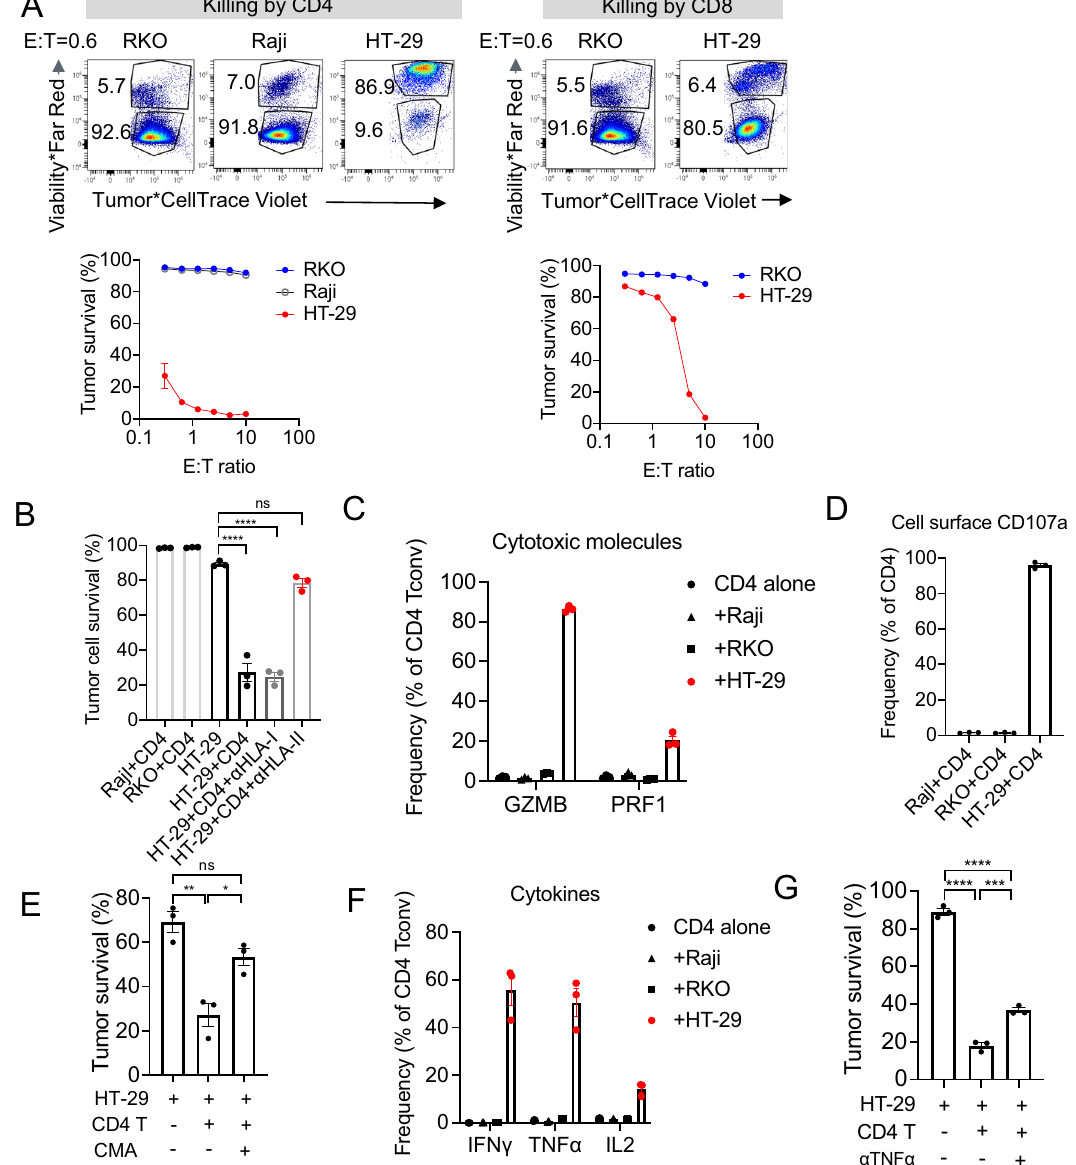
Fig. 6 CD4 T cells mount speci fi c HLA-II-restricted killing of HT-29 tumor cells. A Tumor killing assay using splenic CD4 and CD8 T cells of tumor- regressing mice. CD3 T cells were expanded with HT-29 cells for 2 weeks, followed by CD4 and CD8 T cell isolation and tumor co-culture for 3 days. Tumor cell viability was examined as the readout of the assay. RKO and Raji tumor cells were used as negative controls. E:T ratio: effector to target ratio. B Tumor killing assay using CD4 T cells from regressing tumors with HLA-II blockade. C , D Intracellular staining of cytotoxic molecules at day 2 and cell surface staining of CD107a at the end of the killing assay. E Tumor killing assay using CD4 T cells from regressing tumors in the presence of concanamycin A (CMA) to inhibit the perforin pathway. F Intracellular staining of proin fl ammatory cytokines at day 2 of the killing assay. G Tumor killing assay using CD4 T cells from regressing tumors in the presence of anti-TNF α . N = 3. The results are shown as means ± SEM. * p < 0.05, ** p < 0.01 *** p < 0.001, **** p < 0.0001, one-way ANOVA, Tukey ’ s